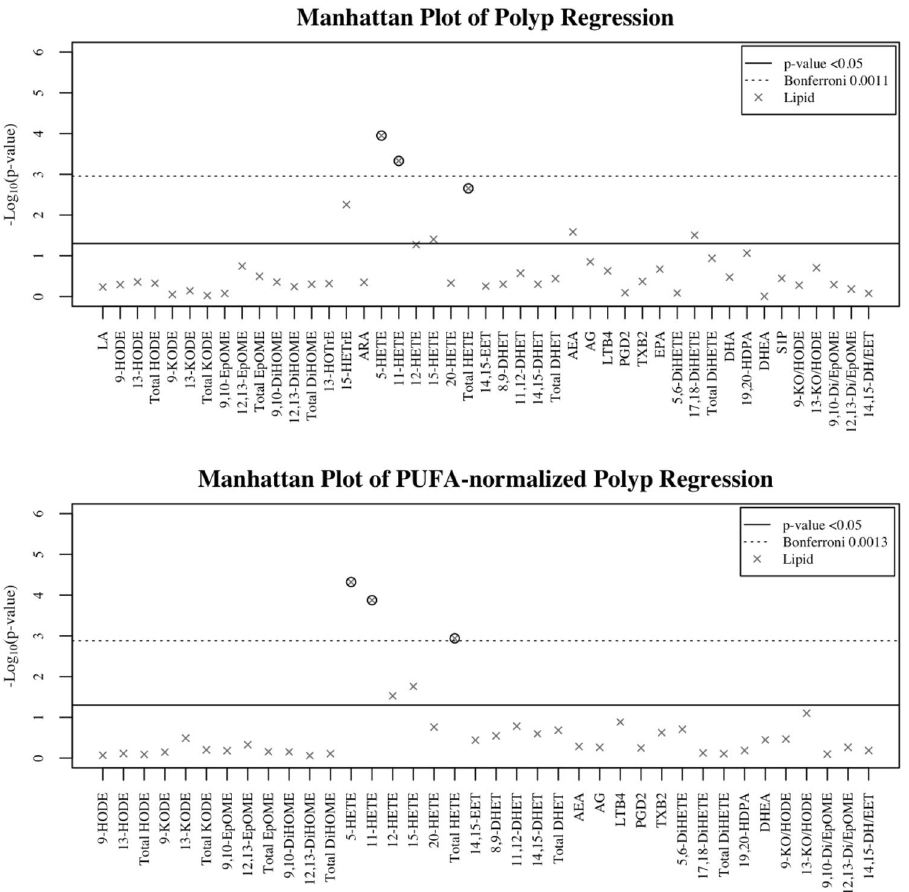
Figure 1. Manhattan plots of polyp type regressed on non-esterified plasma polyunsaturated fatty acids, oxylipids, and PUFA-normalized oxylipids. Manhattan plots of the − log10(p-value) for polyp type regressed on log transformed PUFAs, oxylipids, and oxylipid parent-to-precursor ratios individually (i.e., one at a time). Single non-esterified plasma fatty acid, oxylipid, and product to precursor ratio regression models are defined as: polyp type = age + smoking + log(oxylipid) and polyp type = age + smoking + log(oxylipid/PUFA). Each y-axis represents − log10(p-value) for each respective model, and x-axis represent the plasma non-esterified fatty acid, oxylipid, and oxylipid product-to-precursor ratios. Plasma lipids with Benjamini-Hochberg false discovery rate p-values ≤ 0.05 are circled. Oxylipids totals calculated as follows: Total HODE = ∑ 9-HODE + 13-HODE; Total KODE = ∑ 9-KODE + 13-KODE; Total EpOME = ∑ 9,10-EpOME + 12,13- EpOME; Total HETE = ∑ 5-HETE + 11-HETE + 12-HETE + 15-HETE + 20-HETE; Total DHET = ∑ 8,9-DHET + 11,12-DHET + 14,15-DHET; Total DiHETE = ∑ 5,6-DiHETE + 17,18-DiHETE; 9-KO/ HODE = 9-KODE/9-HODE; 13-KO/HODE = 13-KODE/13-HODE; 9,10-Di/EpOME = 9,10-DiHOME/9,10- EpOME; 12,13-Di/EpOME = 12,13-DiHOME/12,13-EpOME; 14,15-DH/EET =